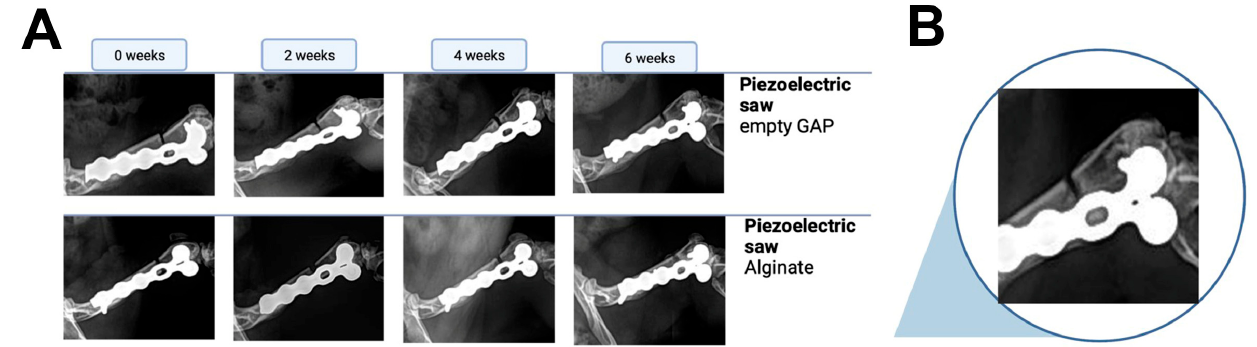
Figure 4. ( A ) Comparison of X-rays left to right from the time of surgery until 6 weeks post-surgery. The top row shows samples without the implantation of an alginate clot, whereas the bottom samples were treated with alginate. ( B ) A close-up of the non-union fracture induced with the piezoelectric saw at 6 weeks post-surgery is shown (representative image of the alginate-treated group).